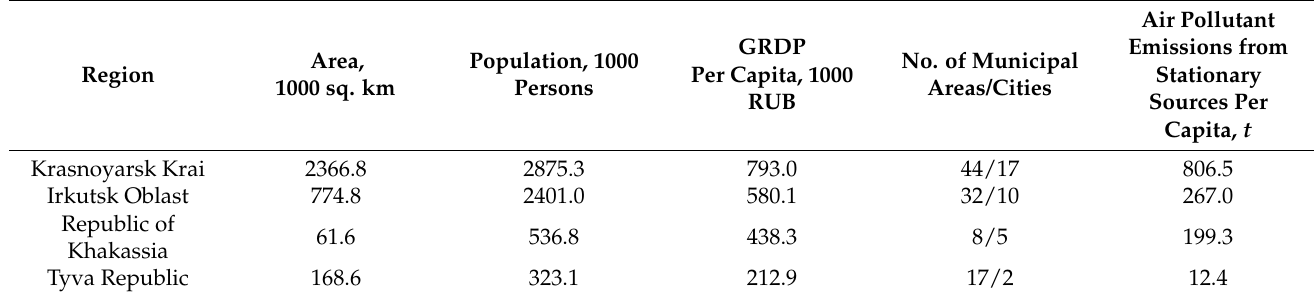
Table 1. Main characteristics of the ensemble of studied regions. Source: Rosstat, Russian Federation State report on the state and protection of the environment 2019. Region